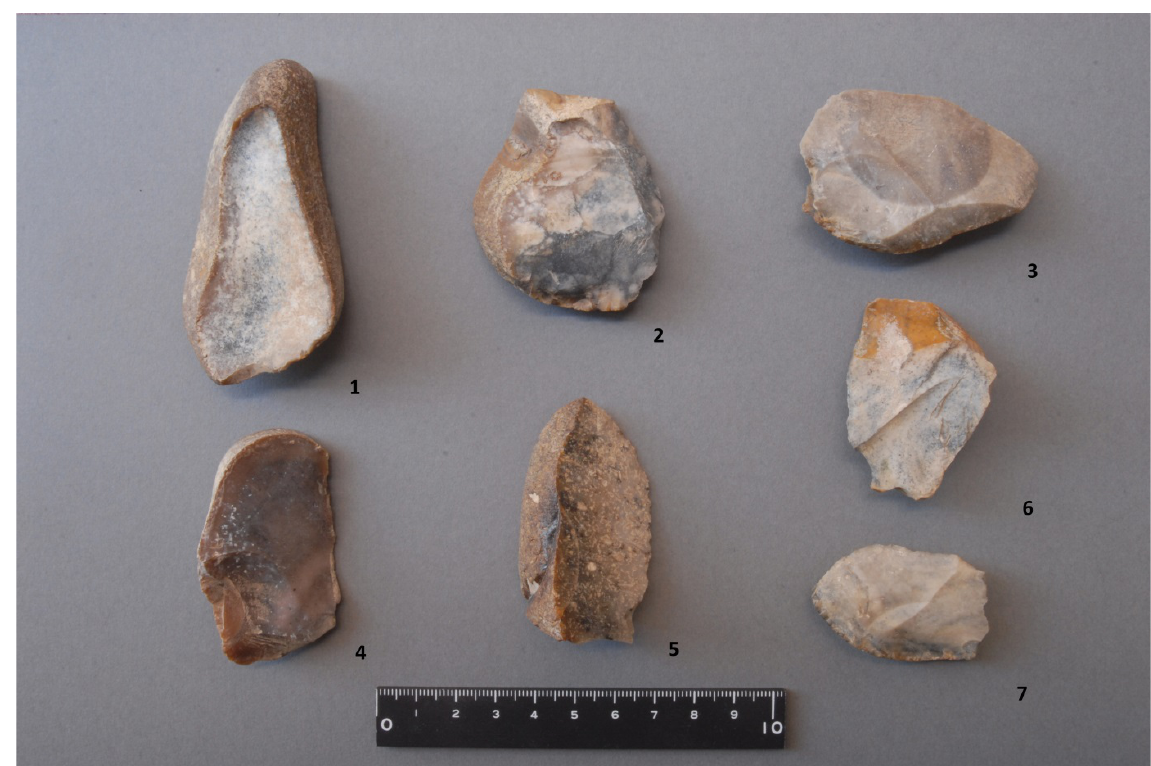
Figure 3. Flakes from a flint scatter at Shabout East (Loc. 20A). Nos. 4 and 7 are